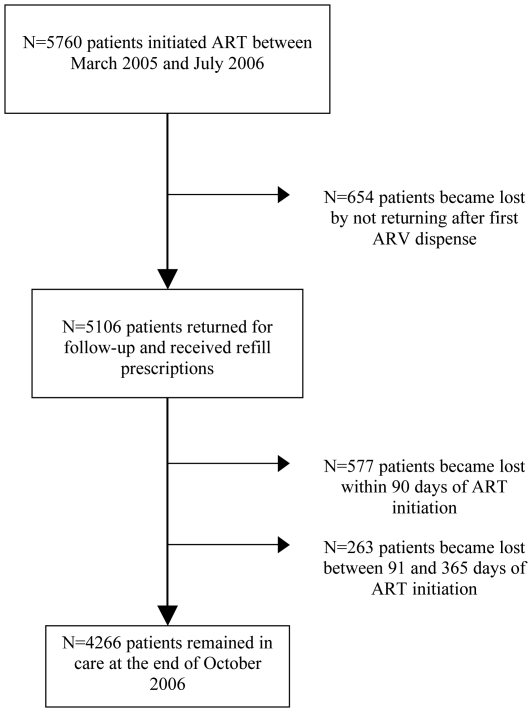
Study Population of Patients Initiating ART between March 2005 and July 2006.